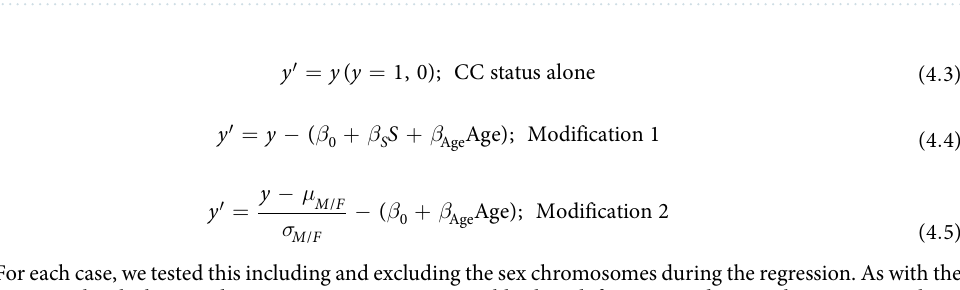
Table 7. Table of prediction results using three types of regressands. All results are on eMERGE and show results for using SNPs, Age, Sex and combinations of